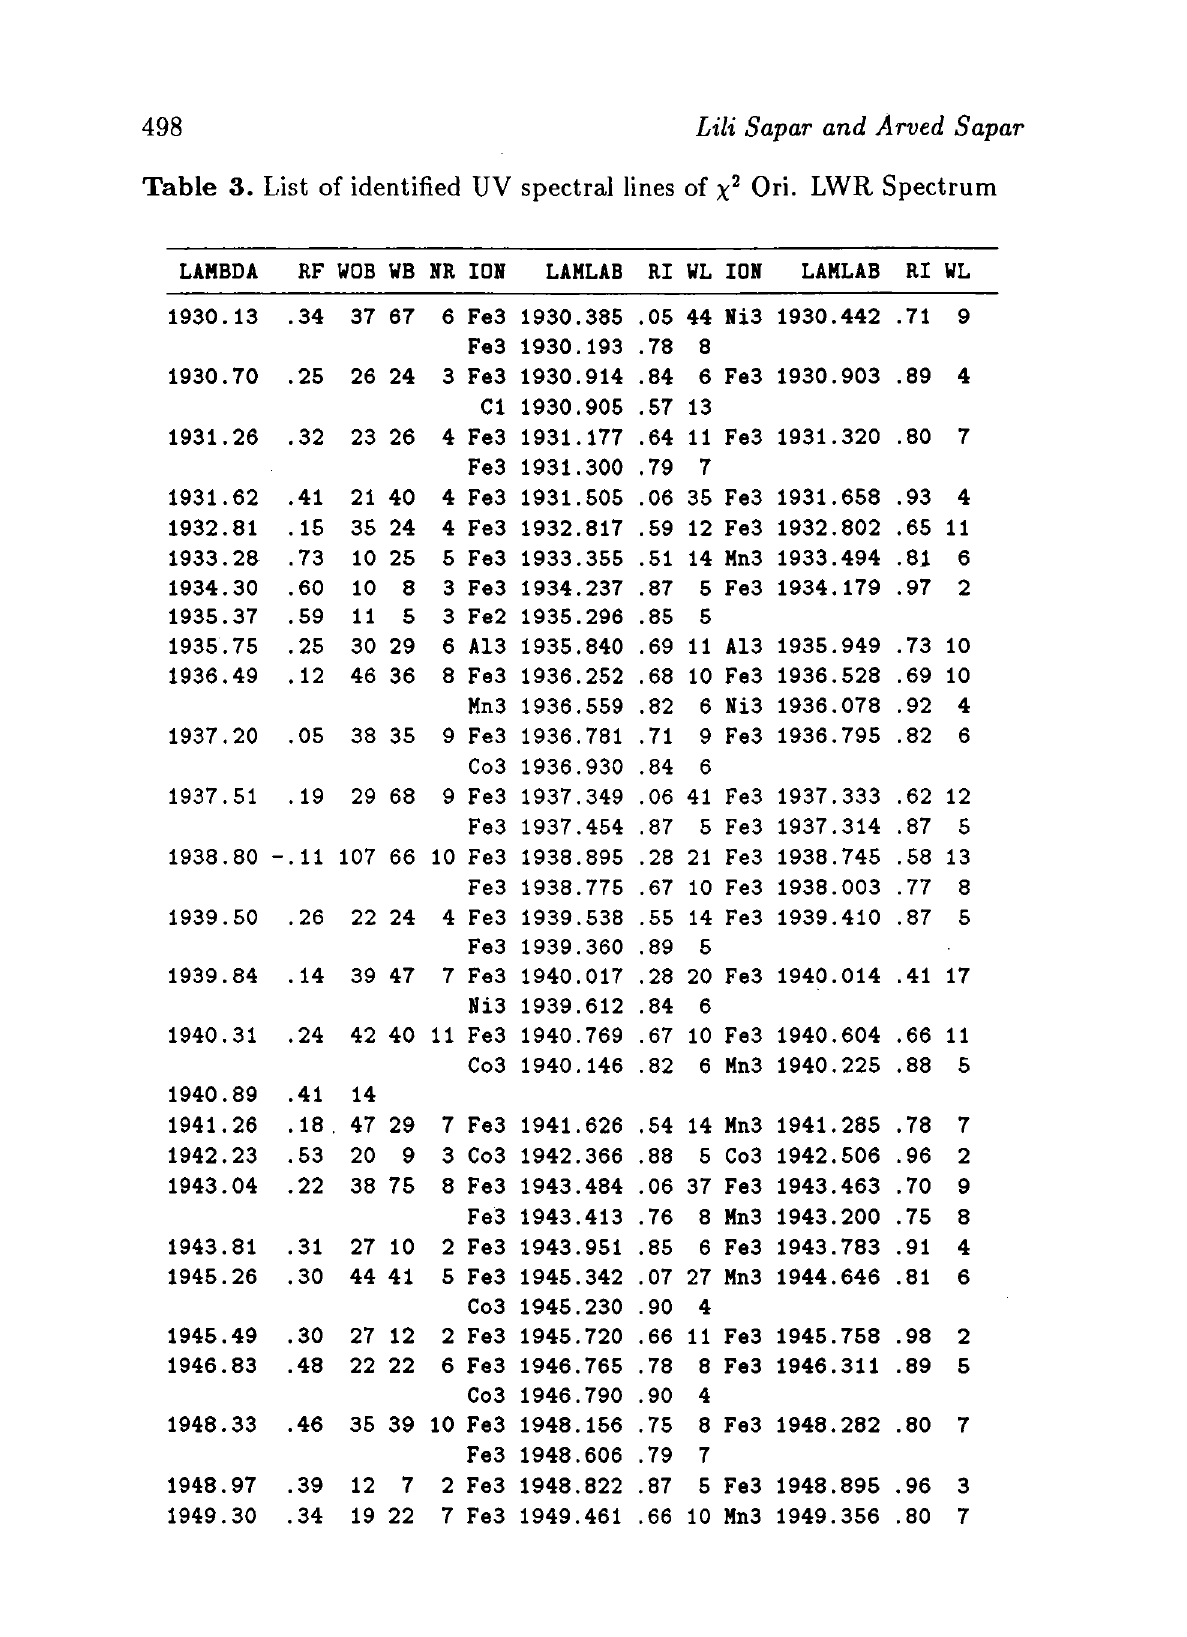
Table 3. List of identified UV spectral lines of x 2 Ori. LWR Spectrum